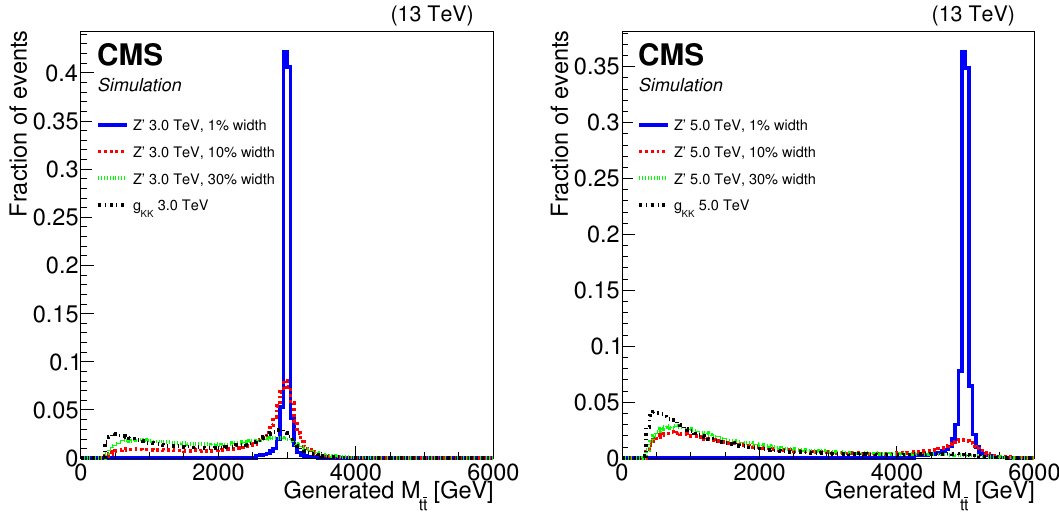
Figure 1 . The tt invariant mass distributions for four signal models with resonance masses of 3 TeV (left) and 5 TeV (right). The g KK resonance has a relative width (cid:0) =m (cid:25) 15{20%, which is between those of the wide and extra-wide Z 0 boson signal